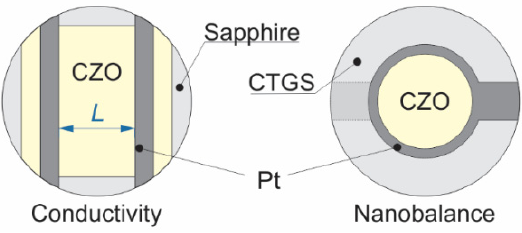
Figure 1. Scheme of Ce 1 − x Zr x O 2 thin film samples deposited on sapphire and Ca 3 TaGa 3 Si 2 O 14 (CTGS) substrates used for studies of electrical conductivity and non-stoichiometry respectively.